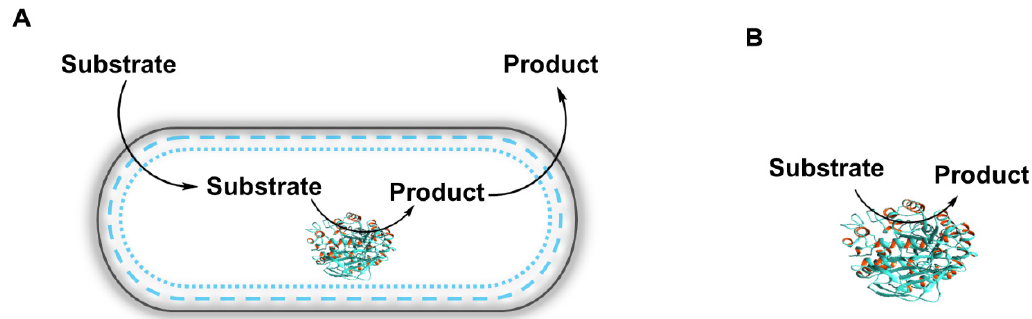
Figure 3. Schematic representations of biocatalytic processes. ( A ) Whole-cell biocatalysis and ( B ) isolated enzyme biocatal- ysis.